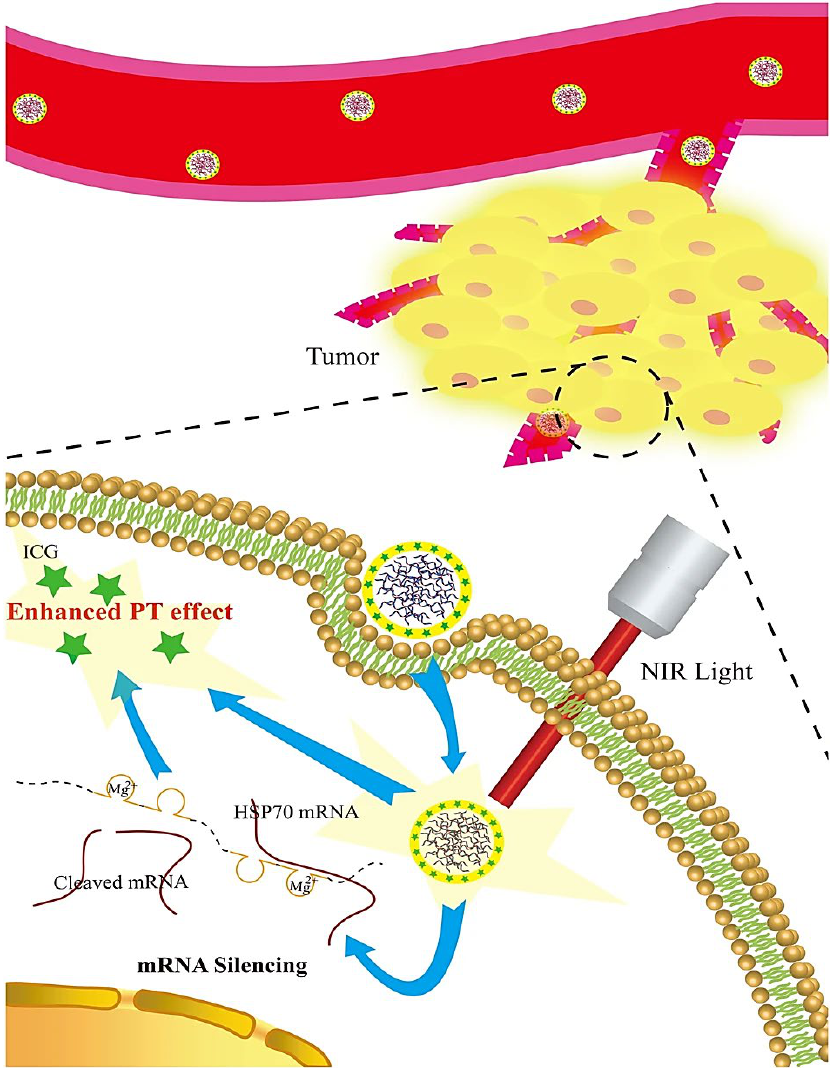
Figure 6. DNAzyme- based nanosponges applied for targeted photothermal therapy of tumors with multimodal imaging potentials. PT: photothermal; NIR: near-infrared; ICG: indocyanine green (photothermal small molecule). Adapted from [69] with permission. Copyright 2018 Springer Nature (CC BY 4.0).